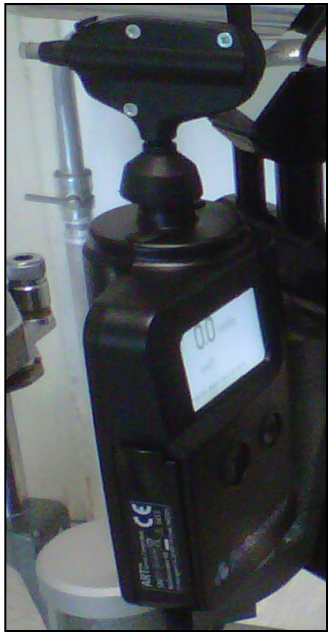
Figure 16. The BioResonator ART